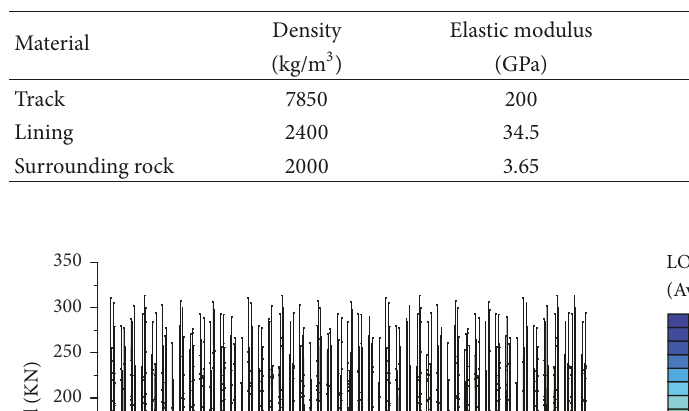
Table 1: Physical and mechanical parameters table.